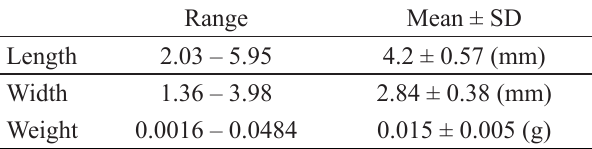
Tab. 2. Range of the measurements observed in the lapillus otoliths of Prochilodus lineatus . Otolith Length, Otolith Wi- dth and Otolith Weight. SD = standard deviation.